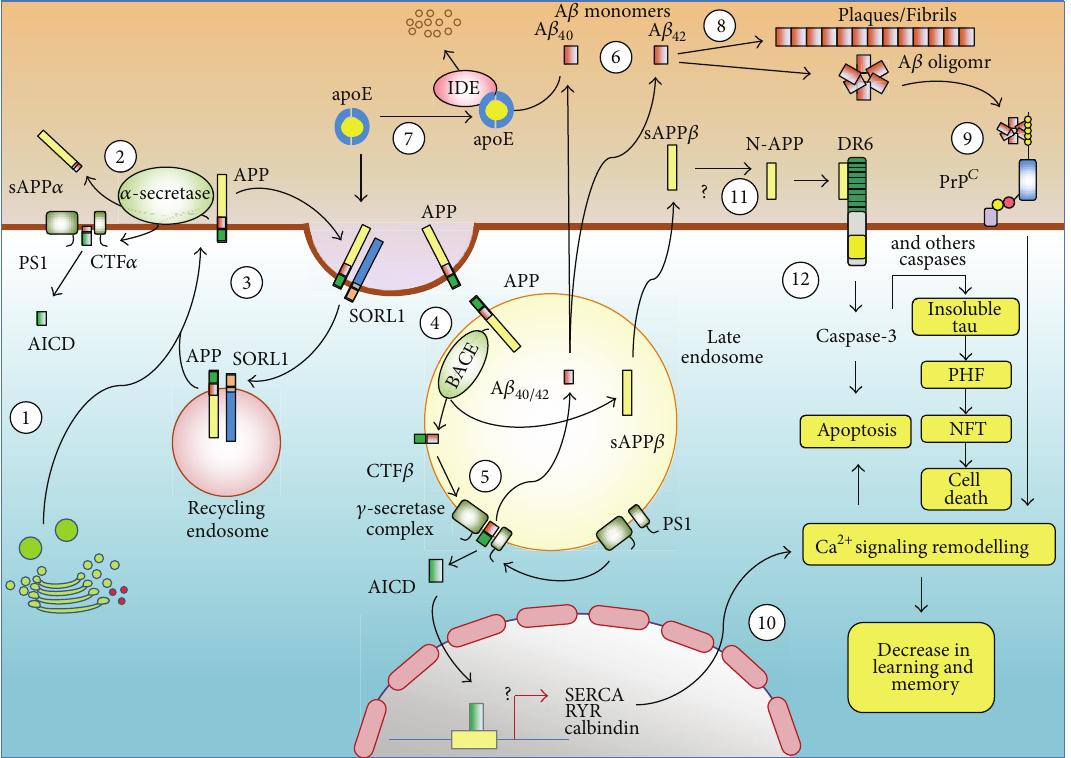
Figure 1: Illustration showing the implication of amyloid and tau hypotheses in the development of Alzheimer’s disease. This modified illustration is reproduced with permission from